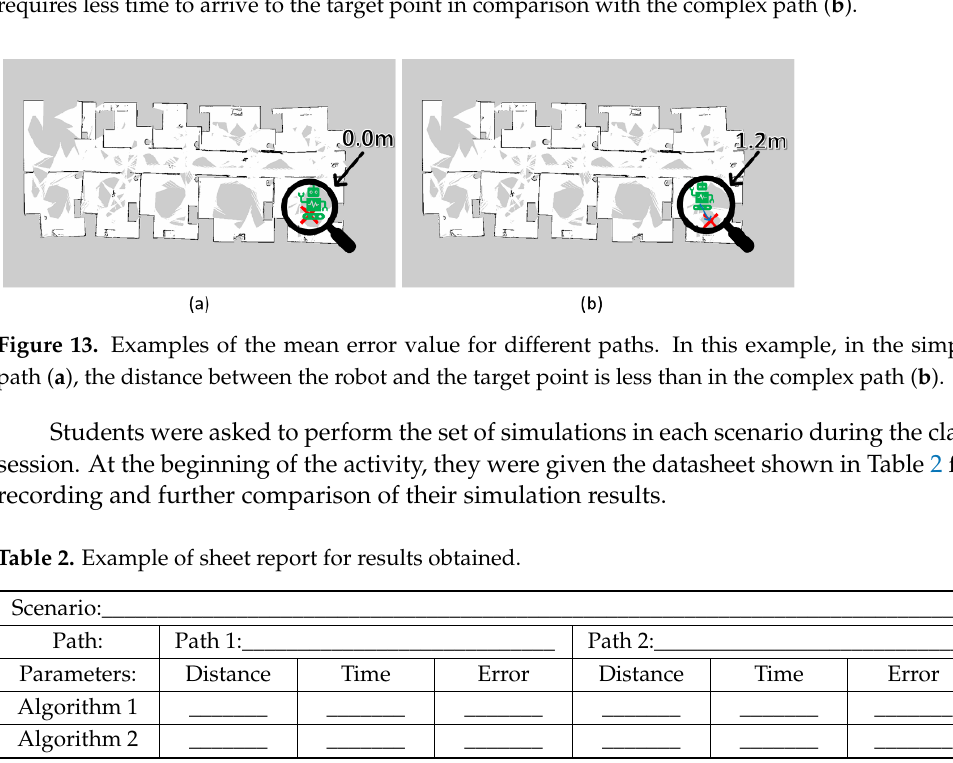
Figure 12. Example of the time for different paths. In this example, in the simple path ( a ), the robot requires less time to arrive to the target point in comparison with the complex path ( b ).